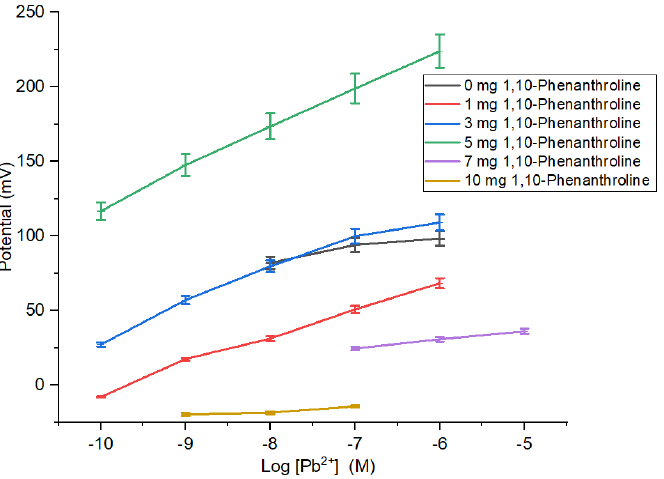
Figure 3. Effect of amount 1,10-phenanthroline on sensitivity and linear range of Pb 2+ ISE.